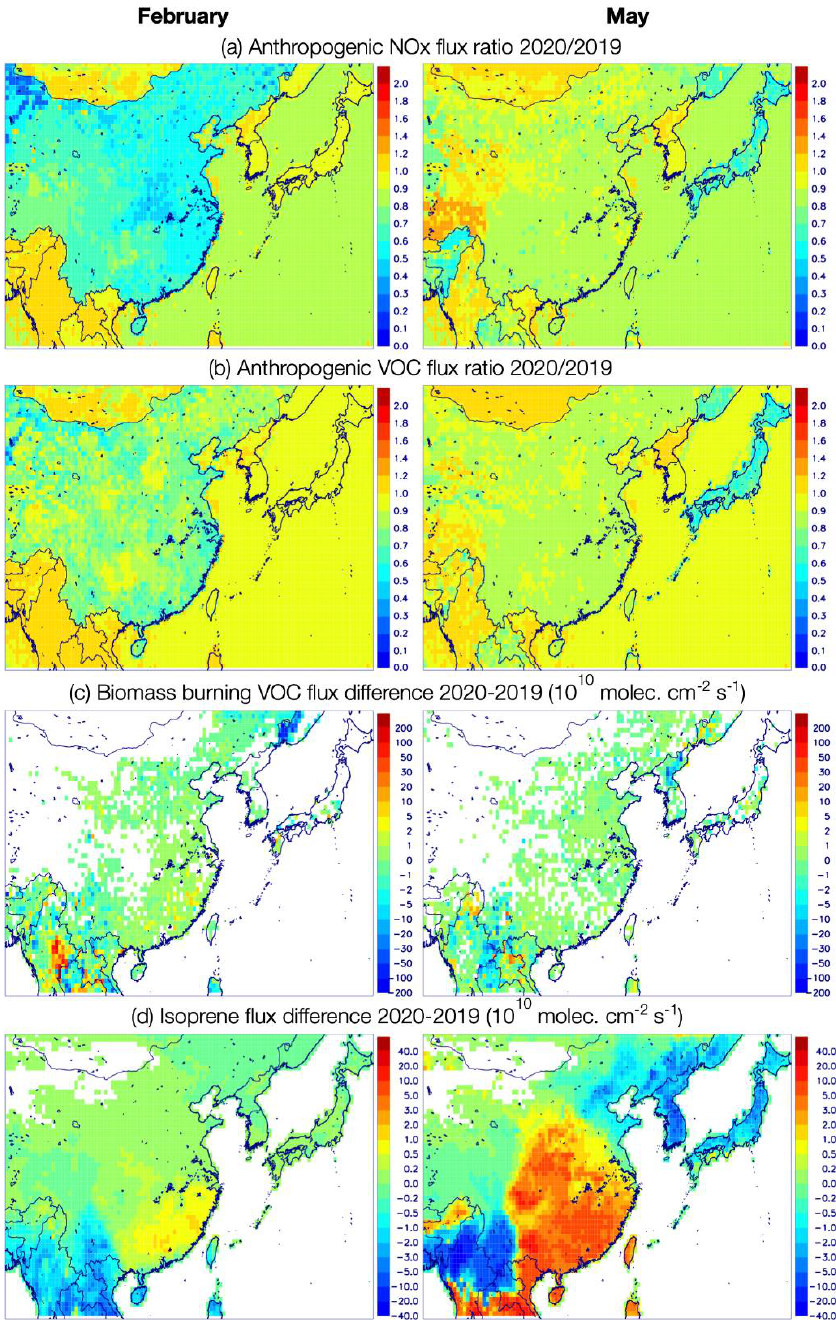
Figure 1. ( a ) Ratio of anthropogenic NO x fluxes, February 2020 divided by February 2019 ( left ) and May 2020 by May 2019 ( right ). ( b ) Idem for anthropogenic VOC fluxes. The anthropogenic fluxes for 2020 are those of the CONFORM dataset [11]. ( c ) Absolute flux difference 2020–2019 for biomass burning VOCs in February ( left ) and May ( right ). ( d ) Idem for isoprene biogenic fluxes.